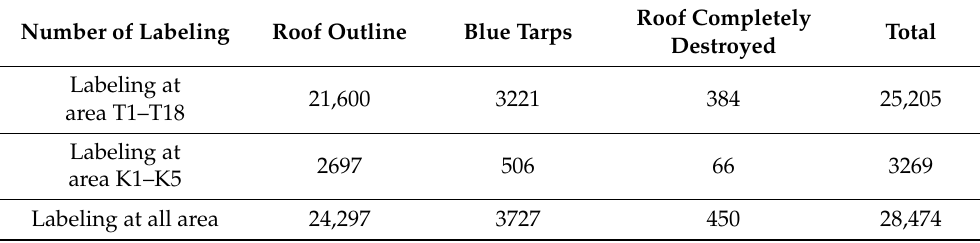
Table 2. Statistics of the labeling data in Figure 3.